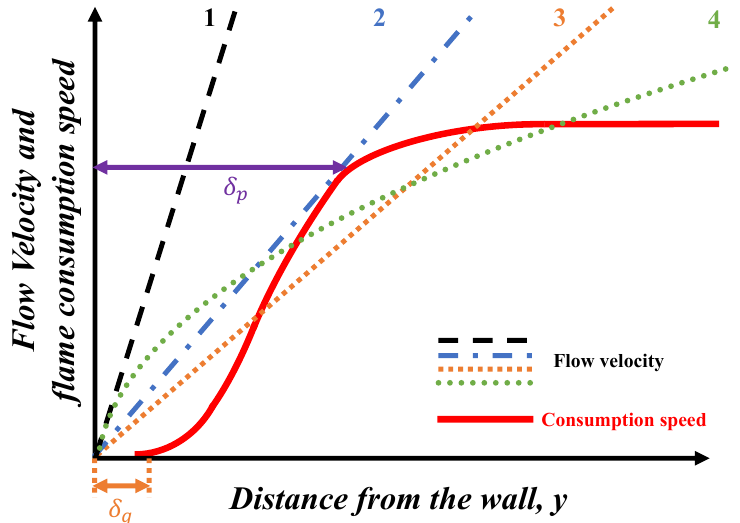
Figure 2. Illustration of the critical condition for the boundary layer flashback. Solid line depicts the profile of the flame consumption speed s c ( y ) , lines 1 to 4 stand for various profiles of the incoming flow